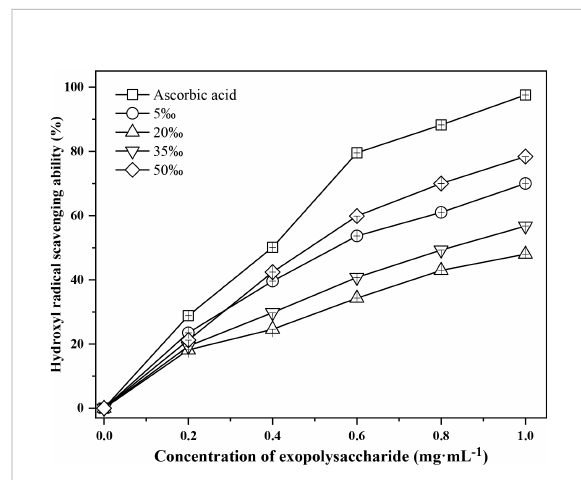
FIGURE 4 Hydroxyl radical scavenging activity of Porphyridium purpureum FACHB 806 exopolysaccharide under different salinities. The values shown are the averages of two biological replicates and three technical replicates ± standard